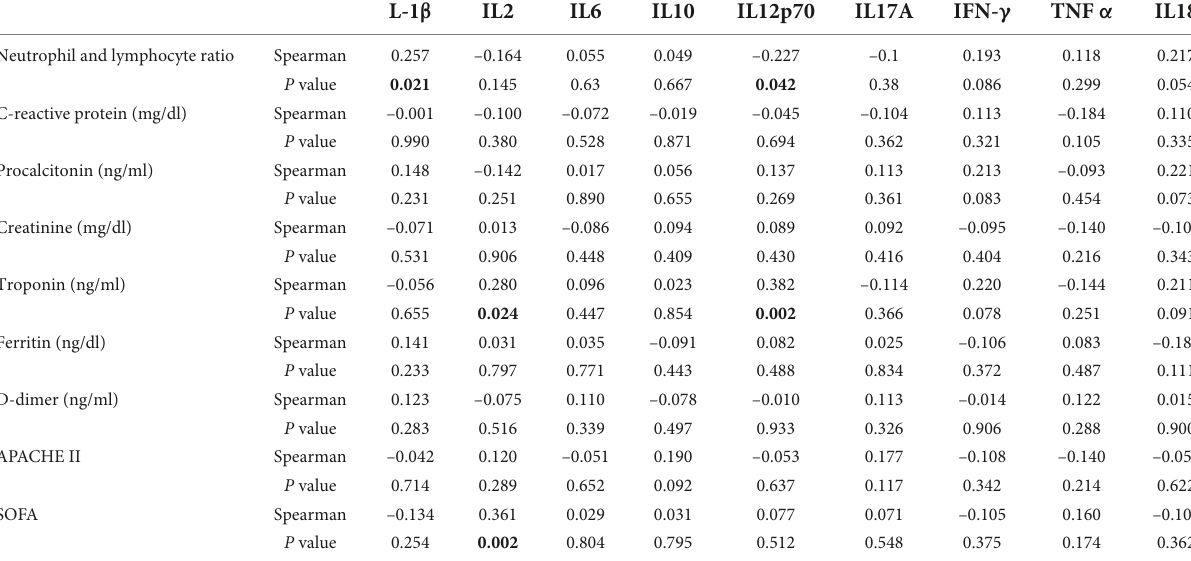
TABLE 4 Correlation matrix between cytokines with severity scores and laboratories at admission.